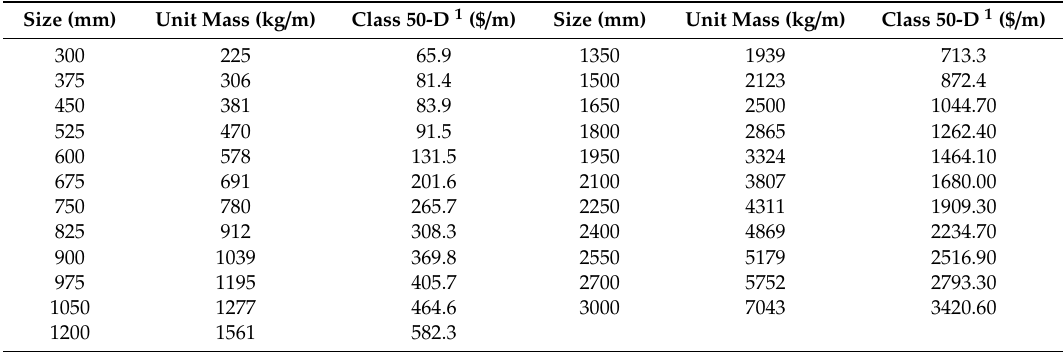
Table 1. Price list of reinforced concrete pipes